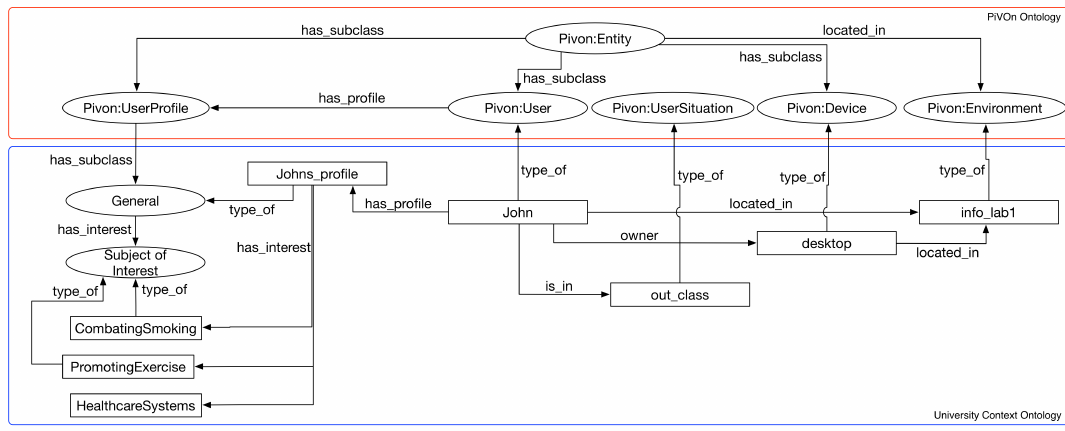
Figure 16. Context of interest related to Storyboard